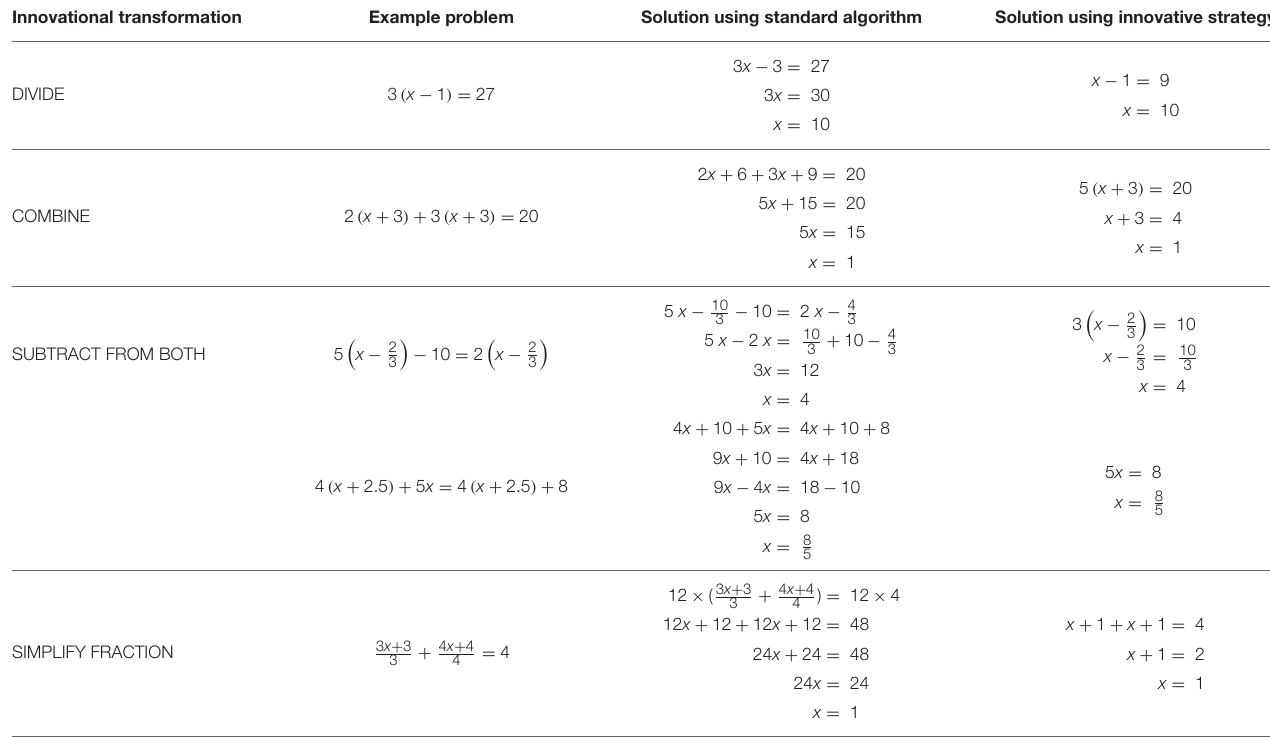
TABLE 1 | Types of shortcuts of example equations attempted on the problem-solving session. Innovational transformation Example problem Solution using standard algorithm Solution using innovative strategy